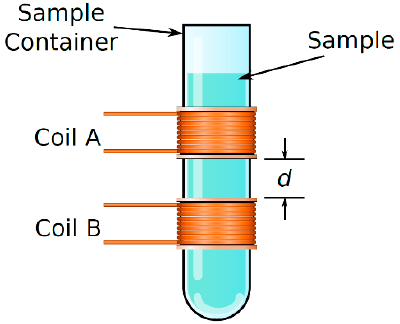
Figure 2. The sensing coils arrangement with the sample container.